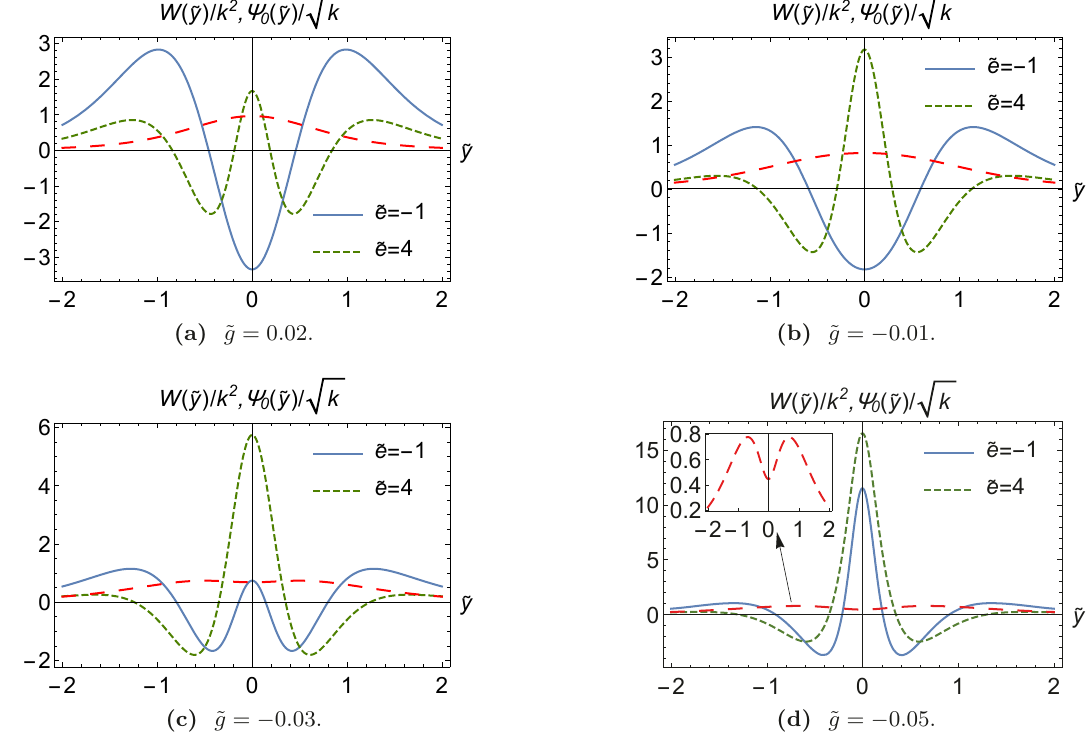
Figure 5. Plots of W (˜ y ) /k 2 and ψ 0 (˜ y ) / √ k with n = 1, where W (˜ y ) is the effective potential in eq. (6.1) and ψ 0 (˜ y ) is the zero mode of the graviton in eq. (5.4) . The blue solid lines and green dashed lines display variations. The red long-dashed lines refer to the zero mode of the graviton corresponding to the effective potentials with the blue